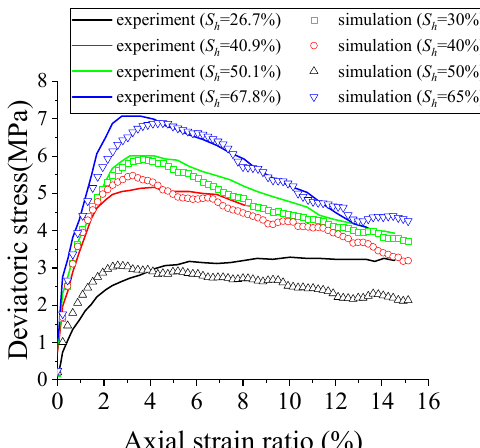
Figure 6. Stress–strain behaviors of methane hydrate-bearing sediments (MHS) with different hydrate saturation ( S h ) levels in laboratory tests and the simulation [42].